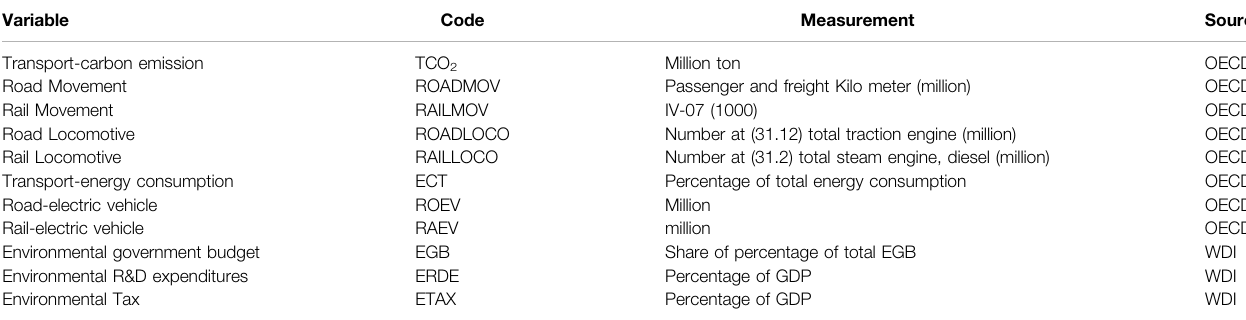
TABLE 1 | Variables and data